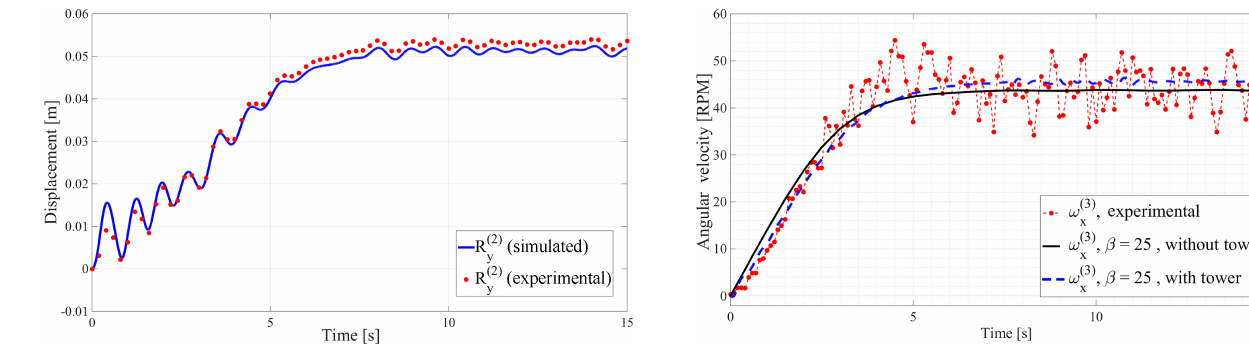
Figure 8. Comparison of rotor velocity at β = 25 ◦ .